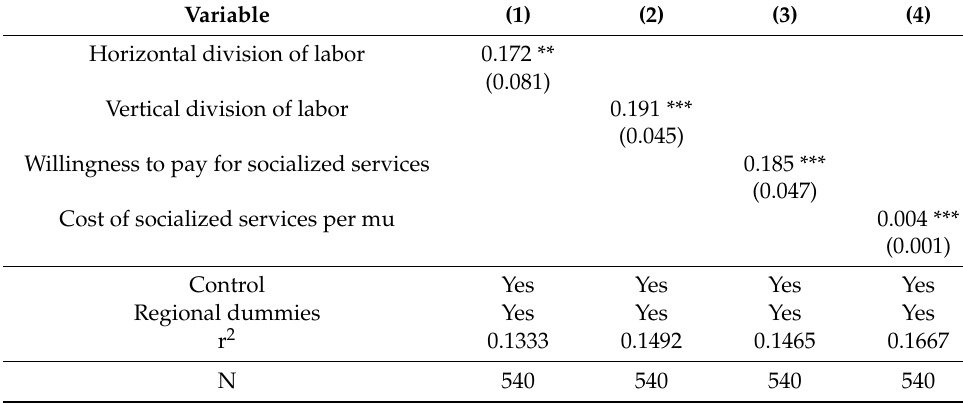
Table 4. Regression results based on the changing model and substituting kernel explaining variables.